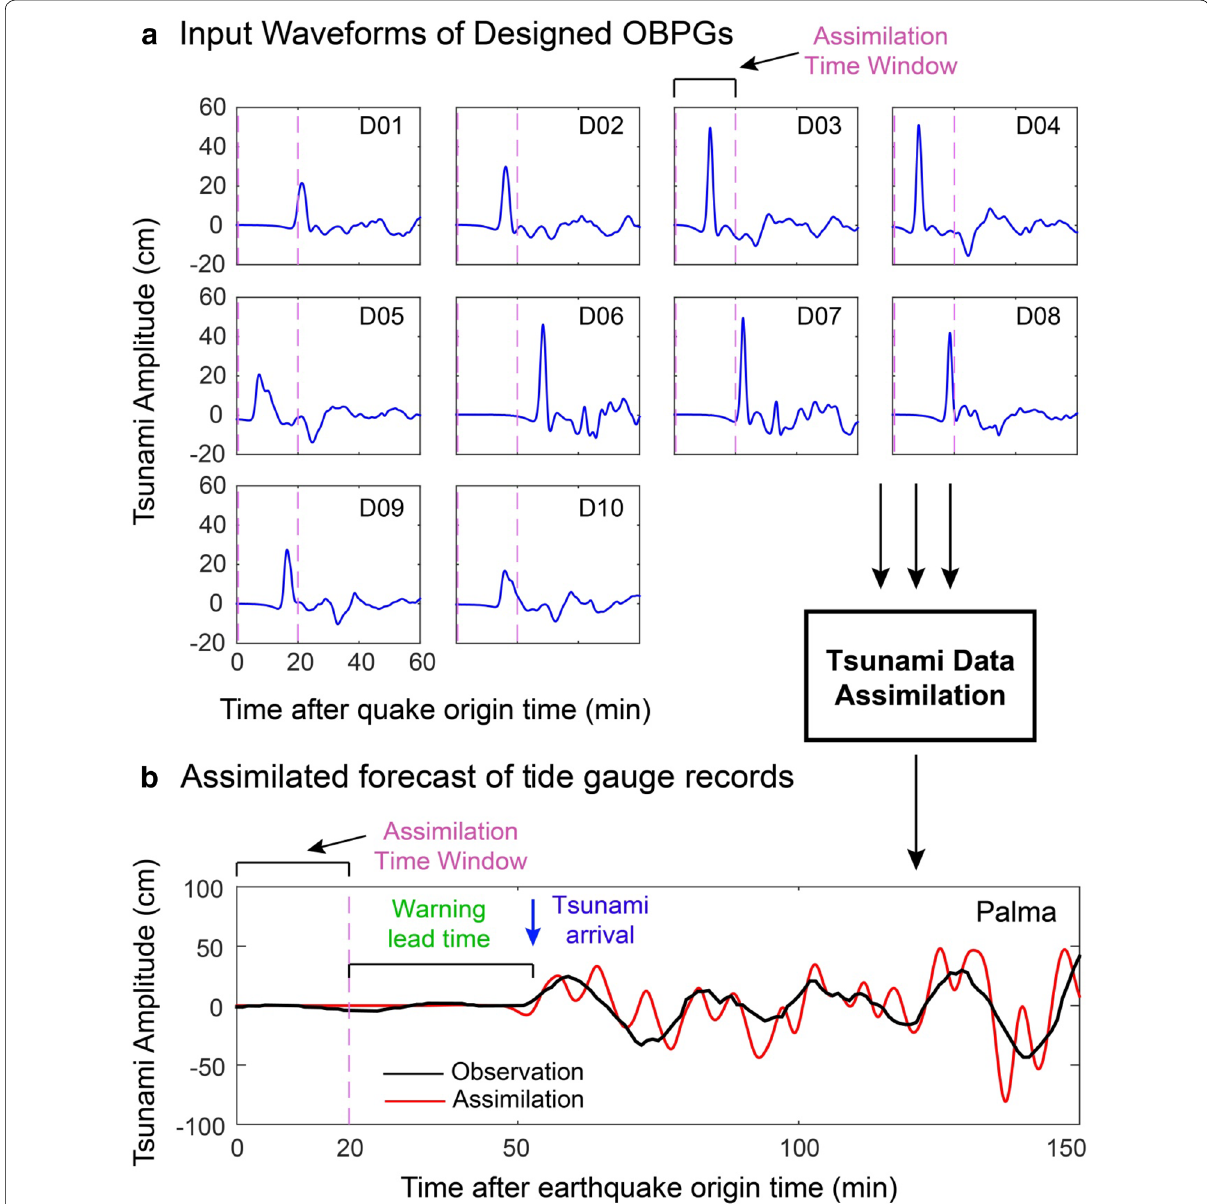
Fig. 5 Tsunami data assimilation process employing 20-min tsunami observation data from the OBPGs ( a ) and the forecasted tsunami in Palma using the tsunami data assimilation method ( b